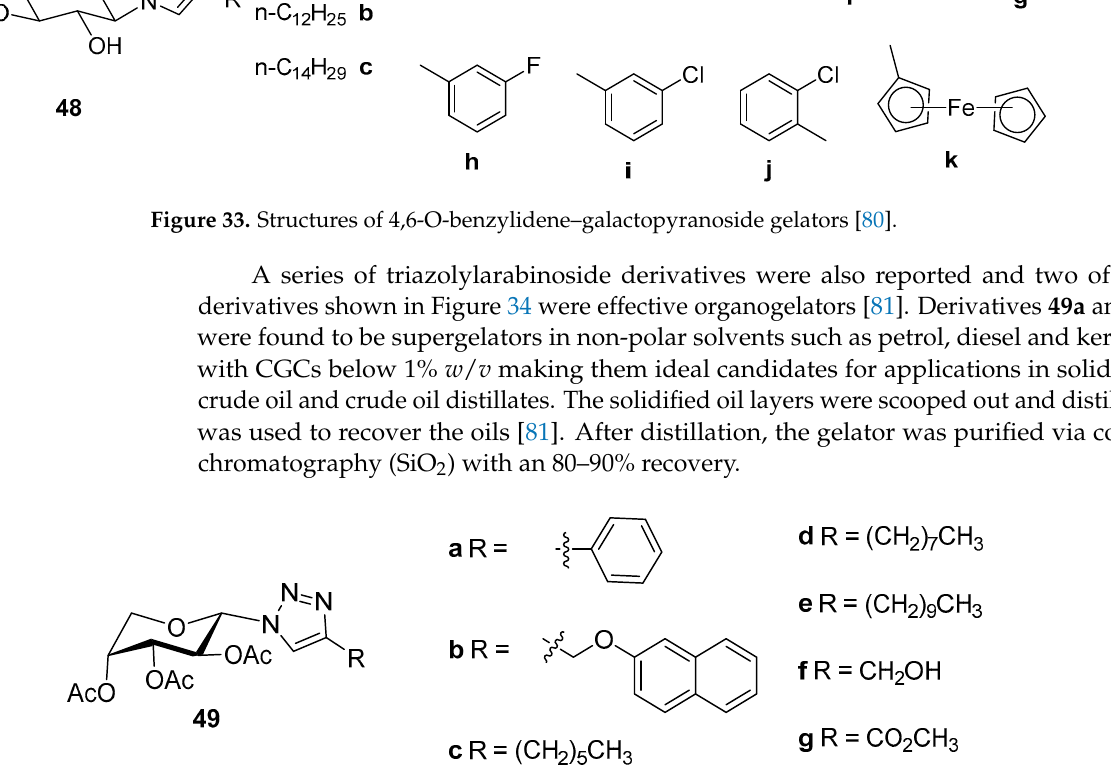
Figure 34. Structures of a series of triazolylarabinoside derivatives [81].